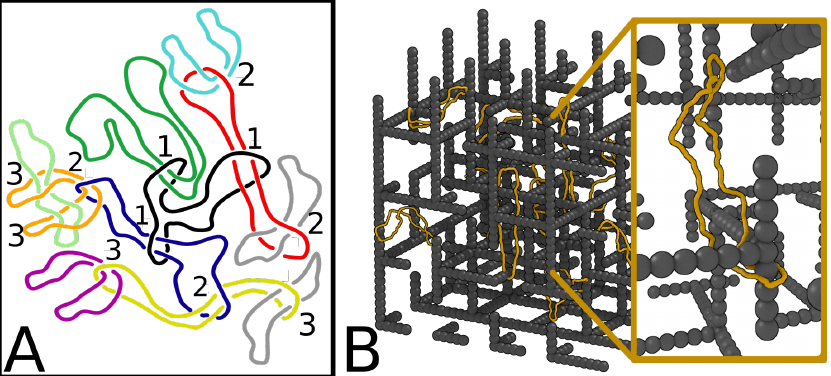
Figure 1. Examples of entanglement, or topological interactions between ring polymers ( A ) or ring polymers and environment ( B ), which cannot be captured by a simple topological invariant, and provide the focus of the current review. Linear (or topologically trivial) polymers, do not experience the same constraints in their motion as ring polymers do in these situations. In ( A ) we report a possible configuration where multiple threadings (inter-penetration) strongly affect the diffusive motion of the central black ring. In ( B ) we report a snapshot from Molecular Dynamics simulations of charged ring polymers (gold) dragged upwards by an external electric field and “impaled” by the dangling ends of a gel (grey), adapted from Reference